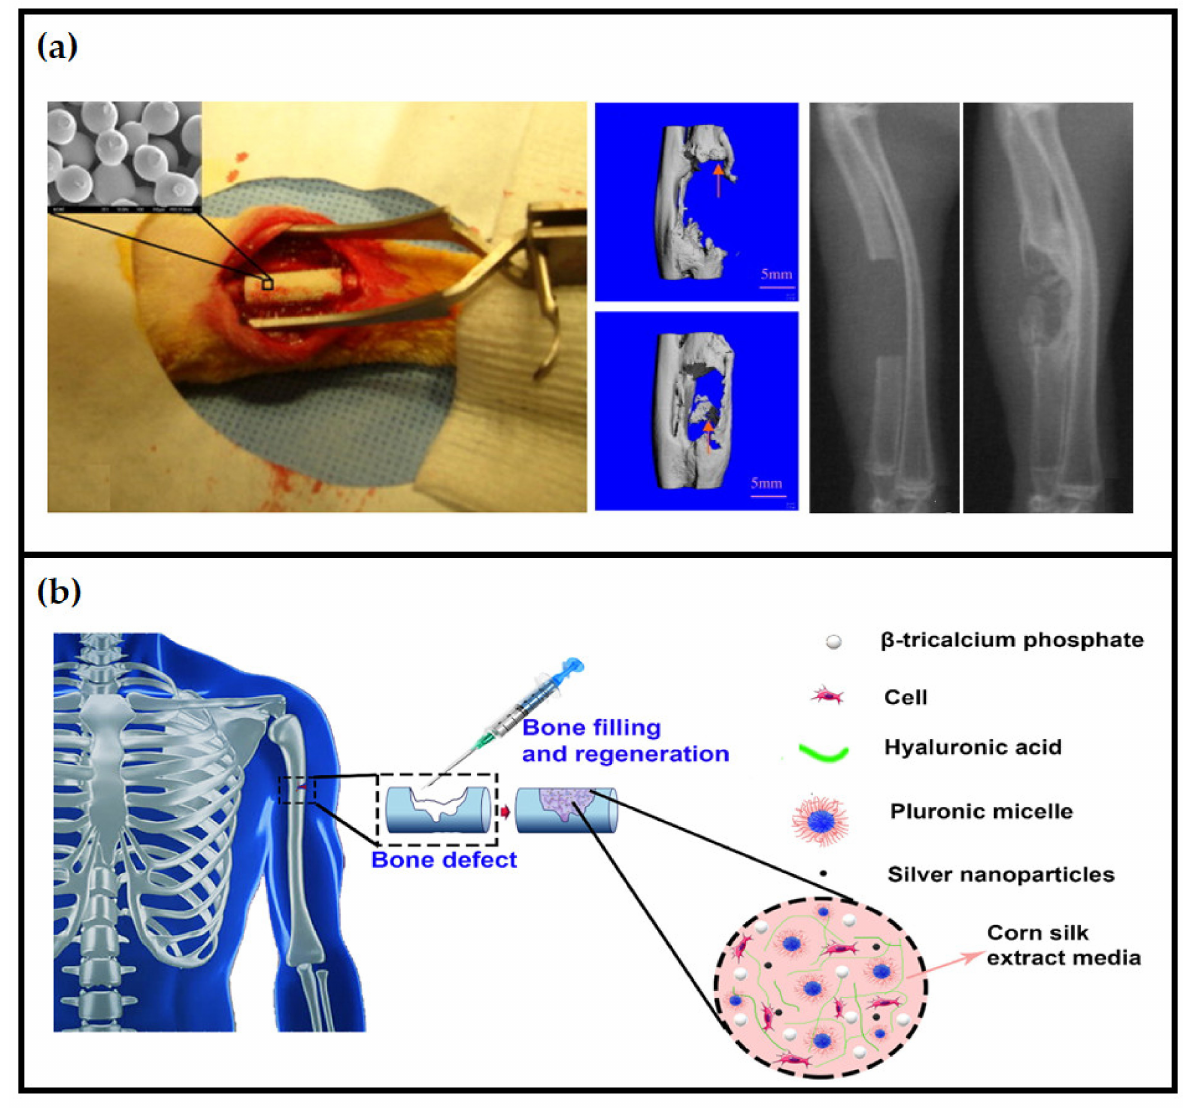
Figure 7. Biopolymer-based scaffolds in bone regeneration: ( a ) implantation of a chitosan/poly(lactide-co-glycolide) scaffold in a 15 mm surgical induced ulna defect and bone regeneration after 12 weeks showing the formation of bridges (adapted Adapted with permission from ref. [144]) 2010 Elsevier; ( b ) injecting the thermo-sensitive hyaluronic acid/corn silk extract composite scaffold containing β -tricalcium phosphate in defected bone for its regeneration (adapted with permission from ref. [95]) 2020